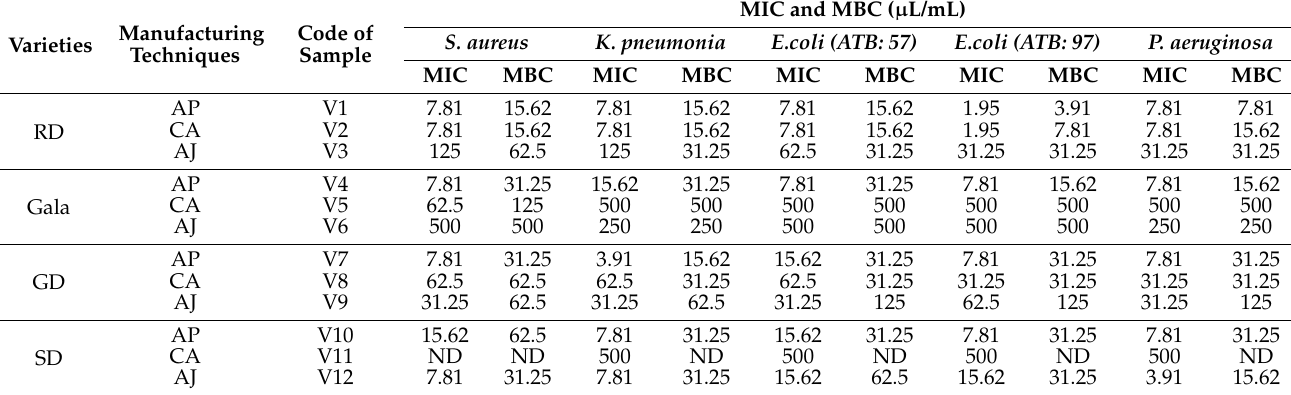
Table 3. Minimal inhibitory concentration (MIC) and minimum bactericidal concentration (MBC) of apple vinegar relative to the bacteria